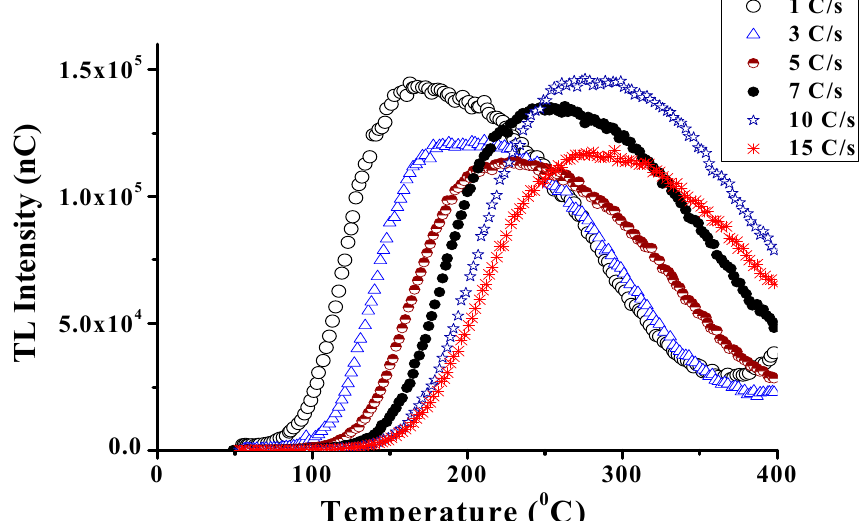
Appl. Sci. 2022 , 12 , x FOR PEER REVIEW Figure 4. Glow curves of S35654 obtained with different heating rates. Figure 4. Glow curves of S35654 obtained with different heating rates.